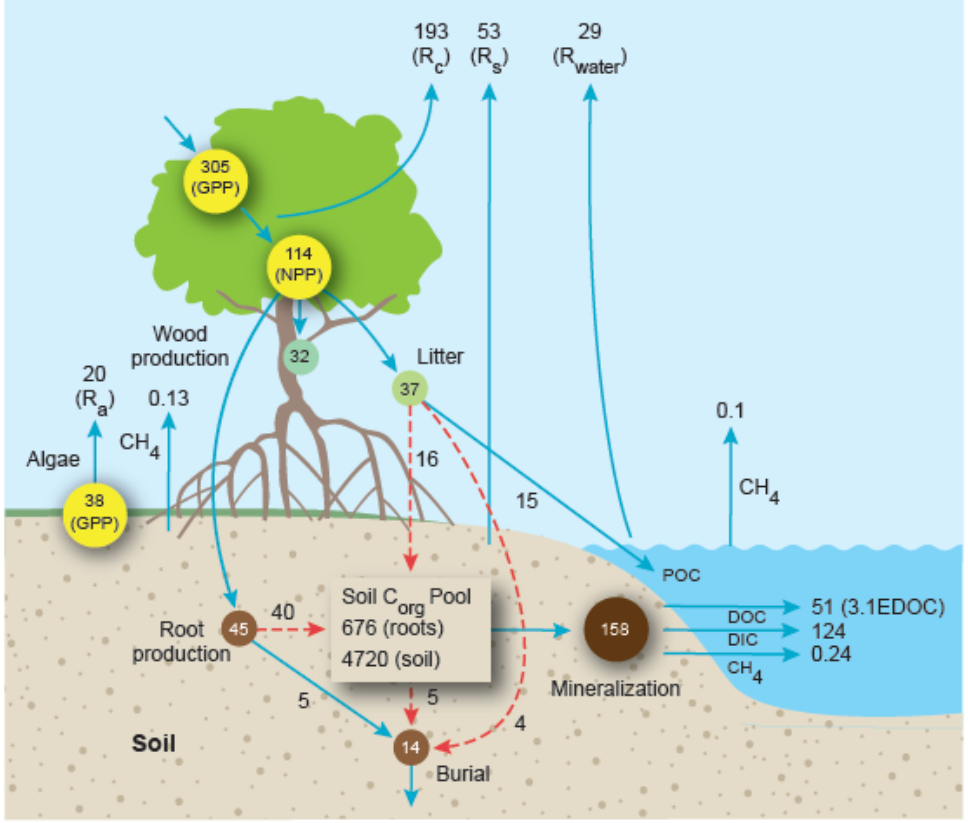
Figure 3. Mass balance of mean carbon flow through the world’s mangrove forests. Units are Tg C a − 1 . The budget assumes a global mangrove area of 86,495 km 2 [94]. Solid blue arrows depict mean values based on empirical data (see text for explanation and references). Dashed red arrows represent mean values estimated indirectly by di ff erence. The C ORG pool (both live and dead roots and other organic matter) in soils to a depth of 1 m is presented in a box in the forest floor with units of Tg C ORG . Abbreviations: GPP = gross primary production; NPP = net primary production; R A = algal production at soil surface and aboveground biomass; Rc = canopy respiration; R S = soil respiration at soil surface; R WATER = waterway respiration; POC = particulate organic carbon derived from litter and exported to tidal waters; DIC = dissolved inorganic carbon; DOC = dissolved organic carbon; CH 4 = methane; EDOC = exchangeable dissolved organic carbon.